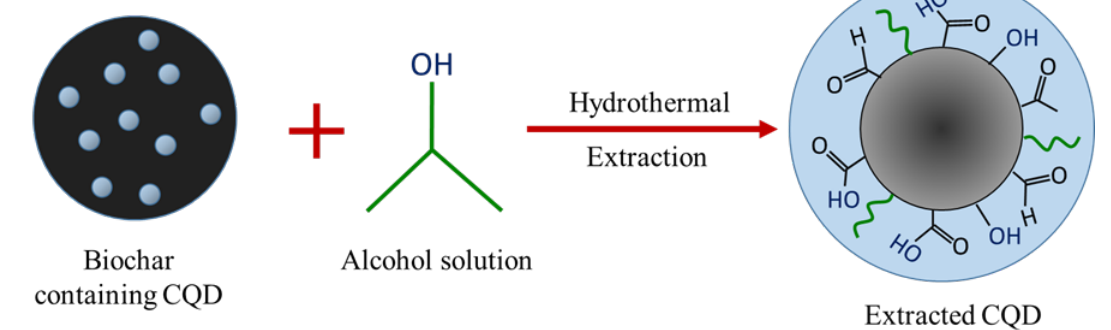
Figure 7. Possible mechanism for the extraction of CQD.